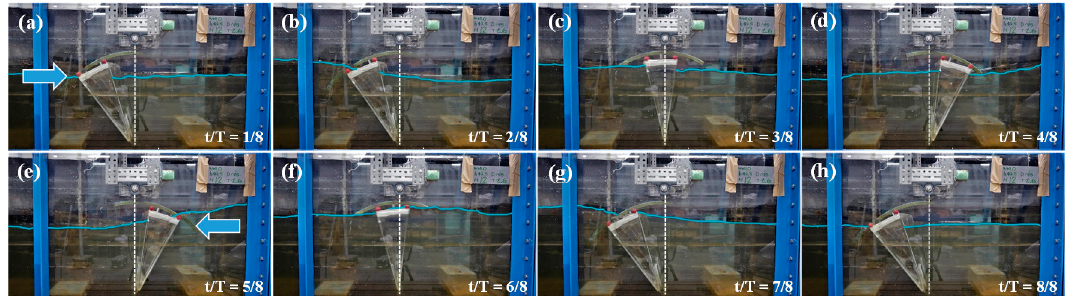
Figure 20. Screenshots of the flap motions for the case of D = 1.45 m, h = 0.425 m, T = 2.6 s, and H i = 0.12 m at ( a ) t / T = 1/8 to ( h ) 8/8. D / L is 0.2852 and k e = 0.44. The blue arrow denotes the wave direction acting on the flap, and the white dotted line indicates the rotational neutral axis of the flap. The blue solid line denotes the water surface.